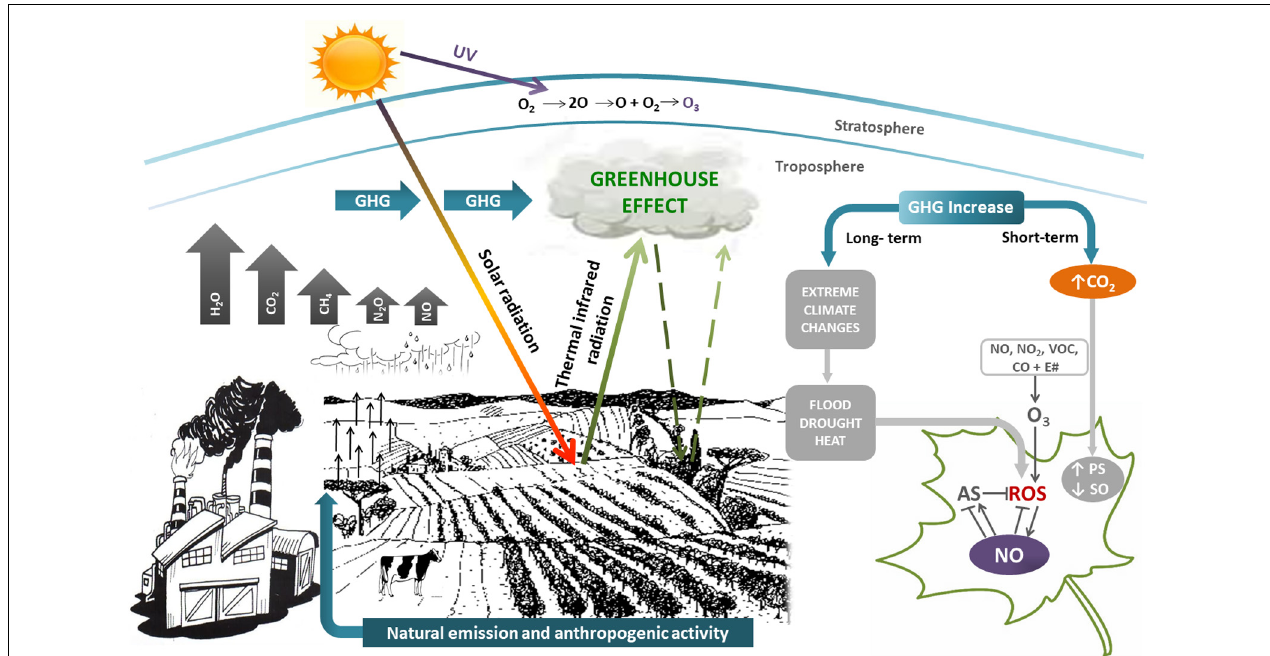
FIGURE 1 | Simplified scheme showing greenhouse gasses (GHG) and their effects on plants. GHG (H 2 O vapor, clouds, CO 2 , CH 4 , N 2 O, and NO) have both natural and anthropogenic origin, contributing to greenhouse effect. Short-term effects of GHG increase is mainly CO 2 rise, that activates photosynthesis (PS) and inhibits stomatal opening (SO). Long-term effects of GHG increase are extreme climate changes such as floods, droughts, heat. All of them induce the generation of reactive oxygen species (ROS) and oxidative stress in plants. Nitric oxide (NO) could alleviate oxidative stress by scavenging ROS and/or regulating the antioxidant system (AS). GHG and volatile organic compounds (VOC) react in presence of sunlight (E#) to give tropospheric O 3 . Although tropospheric O 3 is prejudicial for life, stratospheric O 3 is beneficial, because filters harmful UV-B radiation. The size of arrows are representative of the GHG concentration.